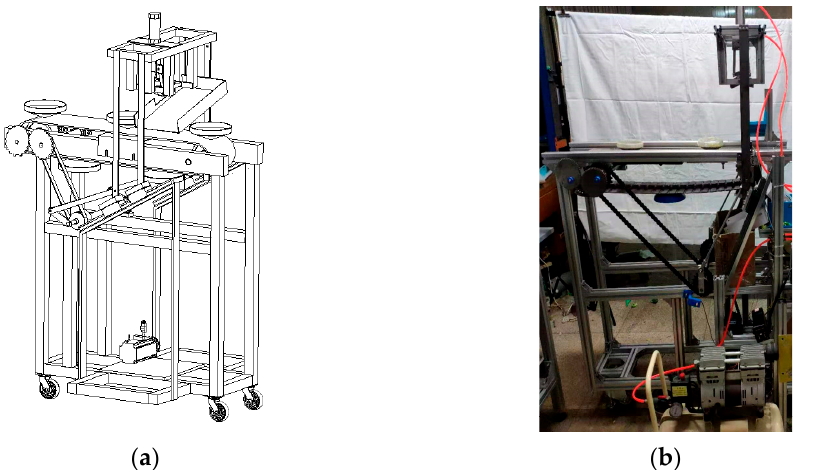
Figure 18. Primary cutting equipment assembly diagram; ( a ) Three-dimensional assembly drawings; ( b ) Photograph.